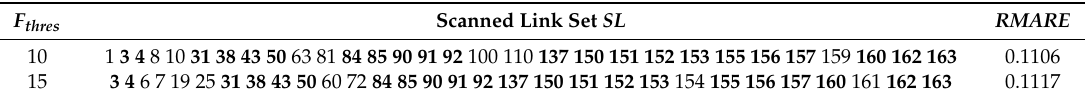
Table 6. Best SL sets obtained from the variability analysis of k